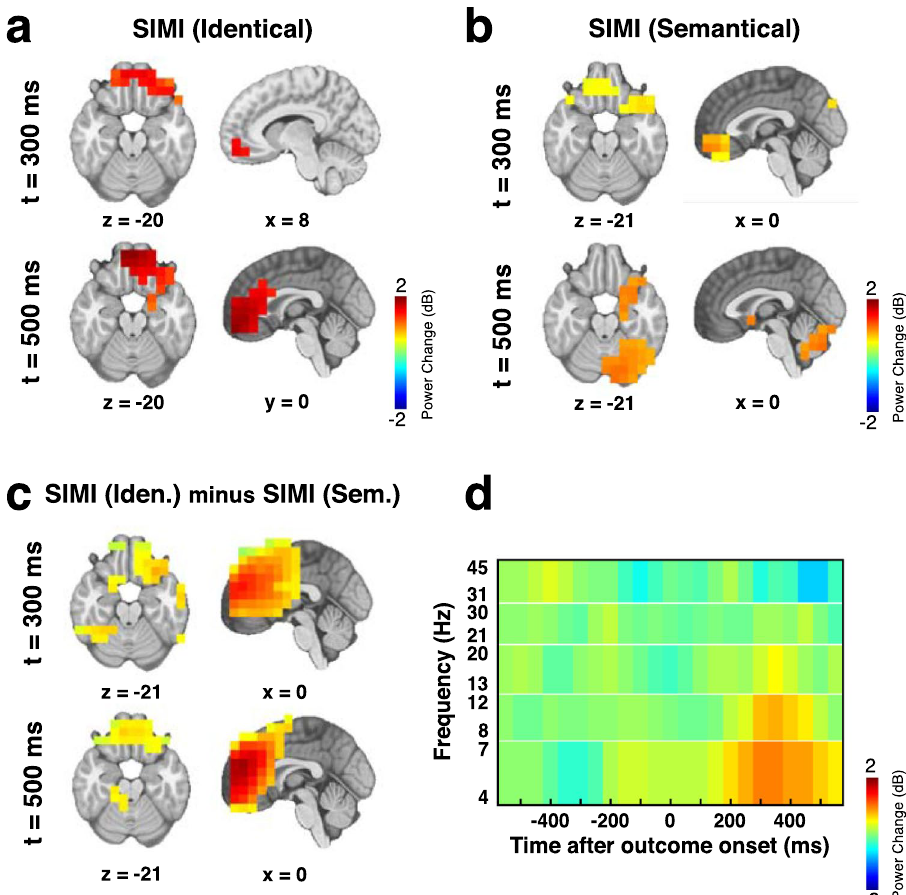
Figure 6. Source-space time–frequency analysis. Brain regions showing a significant (p < 0.05; cluster corrected) modulation of the power in the theta band at 300 and 500 ms following presentation of outcomes SIMI in condition ( a ) “identical”, ( b ) “semantical”; ( c ) difference between SIMI in both conditions. ( d ) Time and frequency distribution of the power difference between SIMI in both conditions observed in the right OFC. One voxel has been selected to illustrate this power distribution. The y-axis represents the frequency bands: theta (4–7 Hz), alpha (8–12 Hz), low beta (13–20 Hz), high beta (21–30 Hz) and gamma (31–45